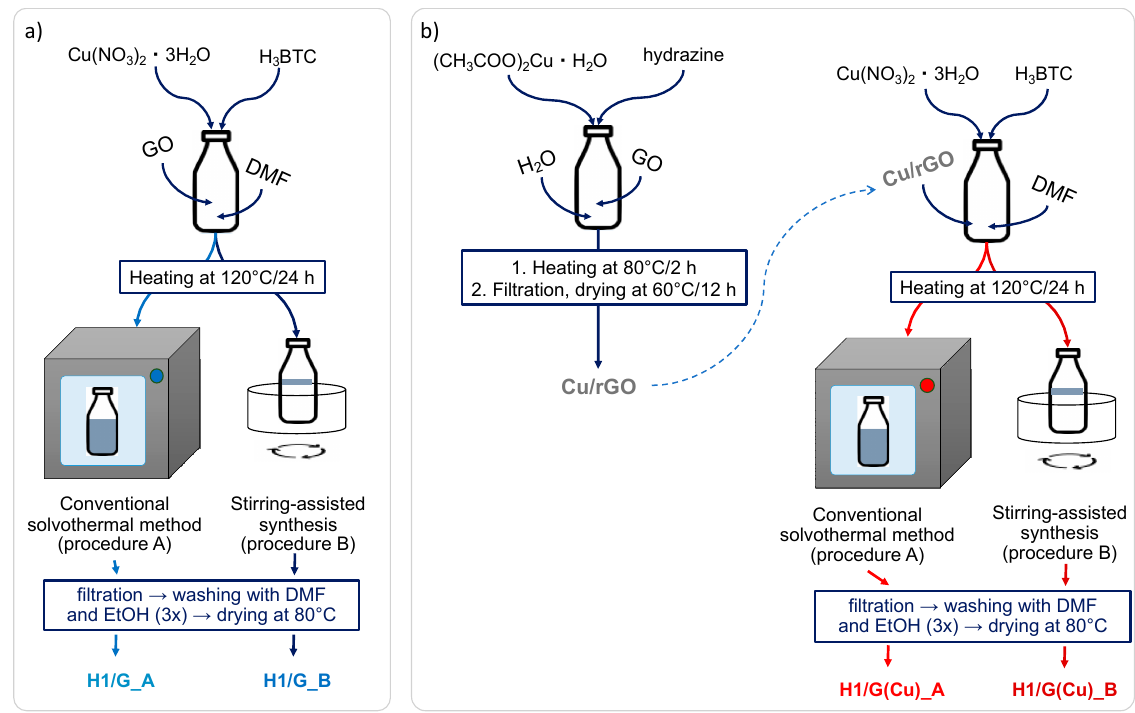
Figure 10 . Synthesis schemes of GO-supported HKUST-1 ( a ) and Cu-decorated supported HKUST- Figure 10. Synthesis schemes of GO-supported HKUST-1 ( a ) and Cu-decorated 1 ( b ).